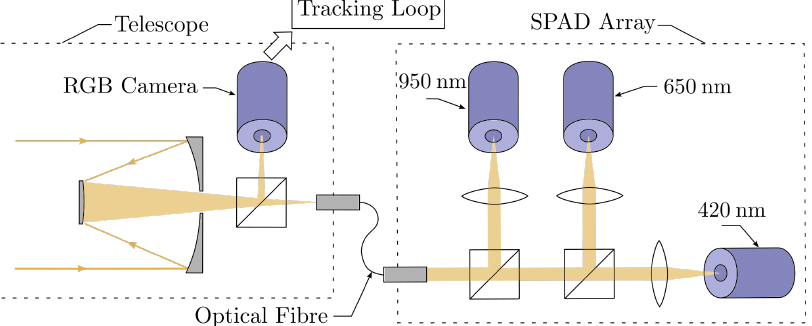
Figure 8. Optical setup used to gather field measurements at the Uhlandshöhe research observatory.